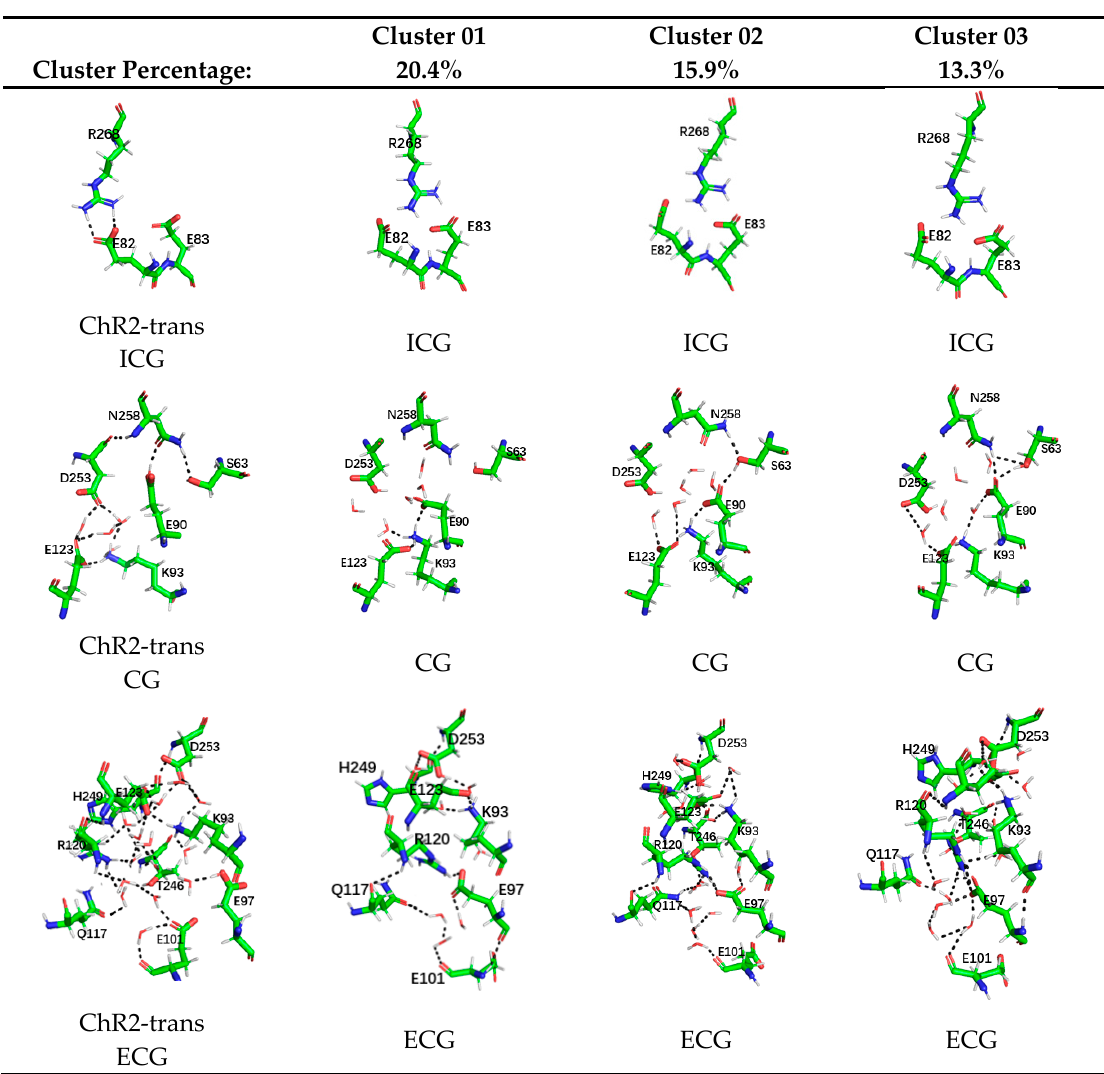
Figure 4. Cluster analysis of ChR2-cis systems. The first column shows the stable structures of the intracellular gate (ICG), central gate (CG), and extracellular gate (ECG), in the equilibrium trajectory of ChR2-trans. The second, third, and fourth columns are the representative conformations of the top three clusters in the ICG, CG, and ECG of ChR2-cis. The cluster percentages are also shown in the figure.